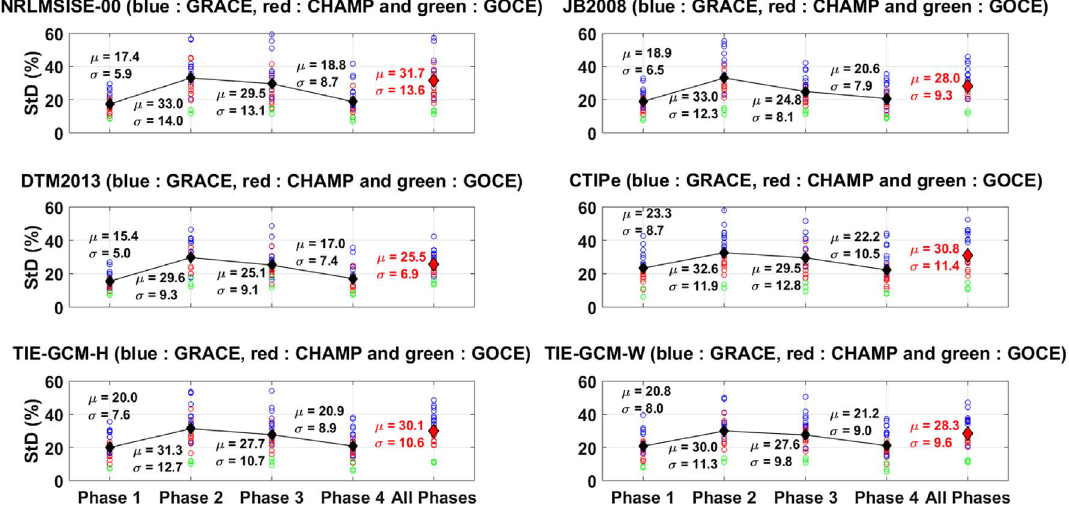
Fig. 5. The mean l and the standard deviation r of the 24 standard deviations of the density ratios (SD; %), per phase (black) and overall (red), using data from three